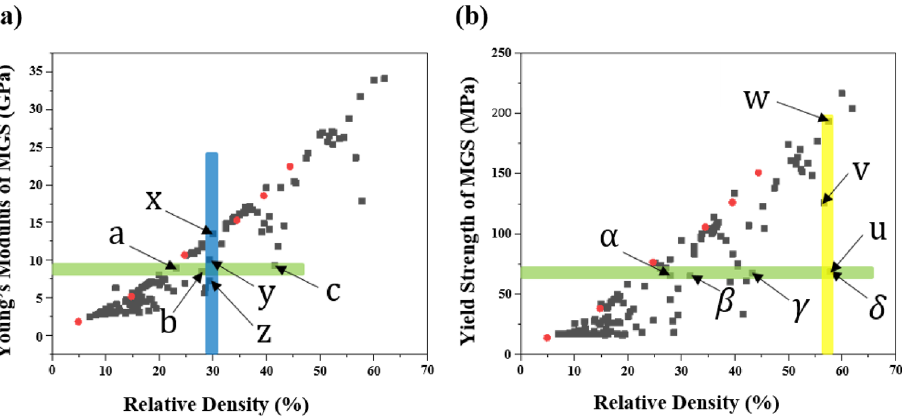
Figure 6. Feasible mechanical properties of MGS with respect to relative density: ( a ) young’s modulus, ( b ) yield strength with respect to relative density. The black dots are originated from 138 MGS structures and the red dots represents the mechanical properties of the repeating sheet-based gyroid.